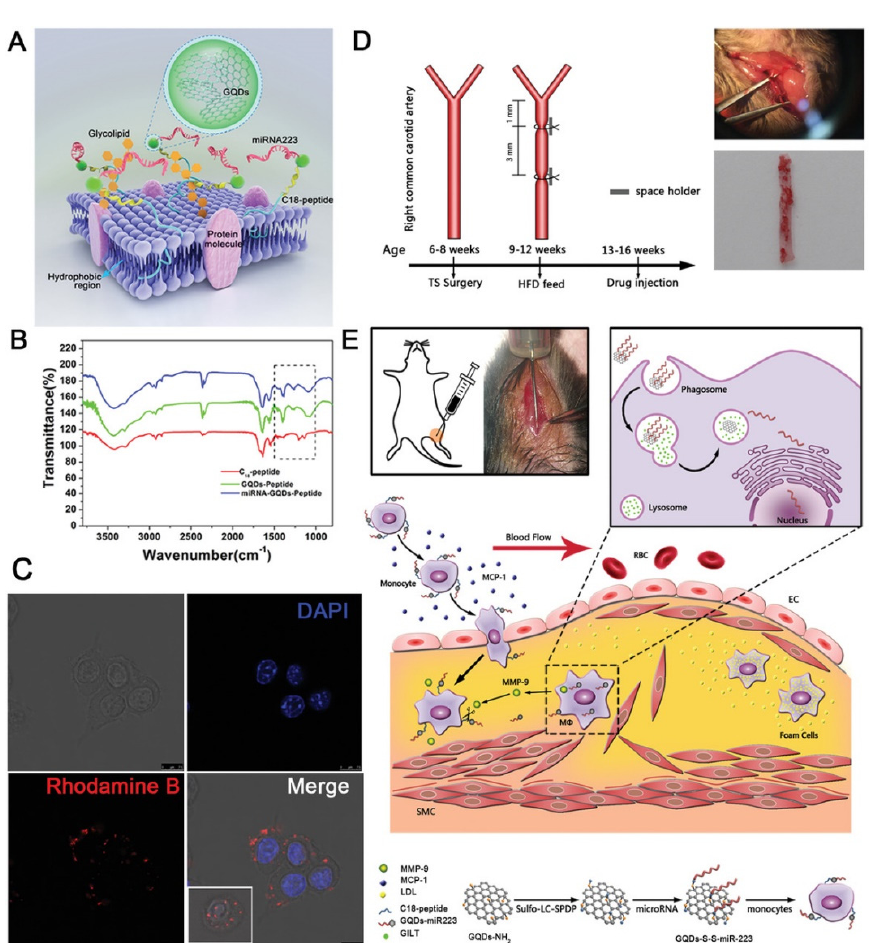
Figure 6. ( A ) Structure of the surface-engineered monocyte. ( B ) FT-IR spectra of C18P, GQDs-C18P, and miRNA223-GQDs-C18P, respectively. ( C ) Confocal fluorescence images of the surface-engineered monocyte. ( D ) Animal modeling process: partial ligation of the RCCA in Apoe − / − mice 6–8 weeks of age; continued feeding with a high-fat diet for the 4 weeks after surgery; femoral vein injection after feeding with a high-fat diet for 4 weeks. Top, optical photograph of the surgery; bottom, microscopic image of the oil-red-O-positive area. Scale bar = 100 µ m. ( E ) Delivery mechanism of monocyte-C18P-GQDs-miR223 in vivo. Reproduced with permission from [181]. © 2022 WILEY-VCH Verlag GmbH & Co. KGaA, Weinheim.